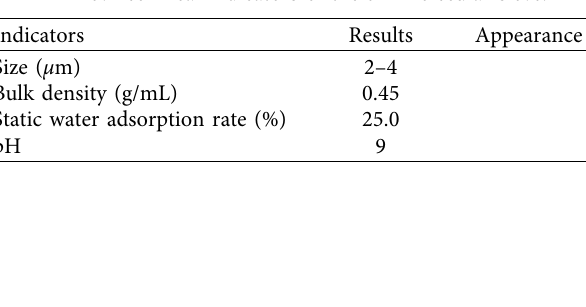
Table 4: Performance parameters of cement.